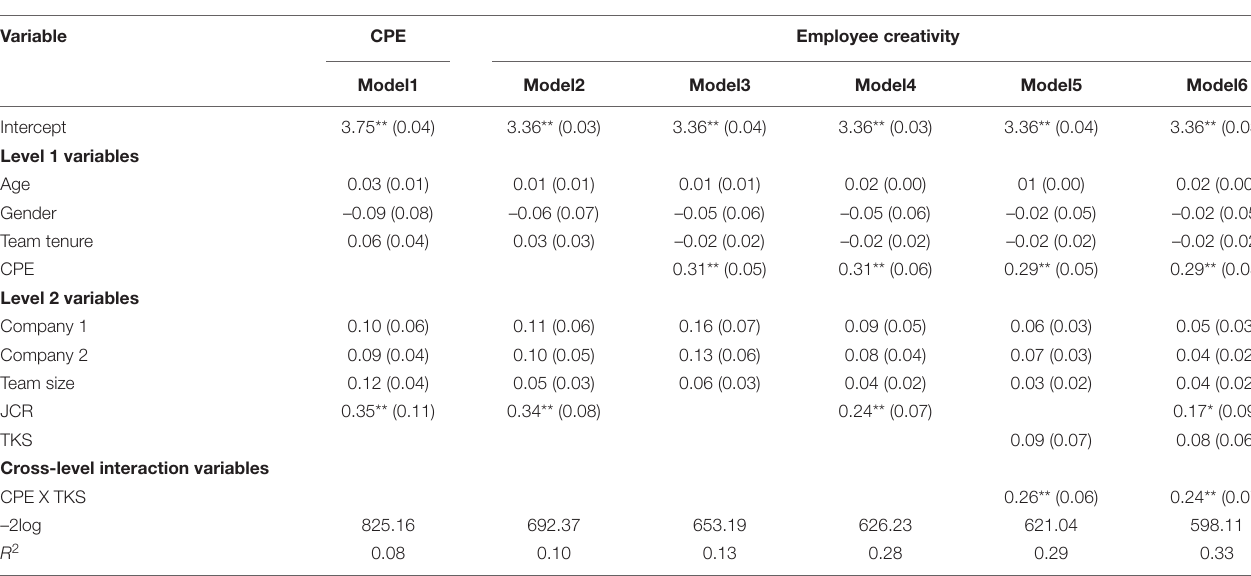
TABLE 2 | Hierarchical linear model (HLM) analysis